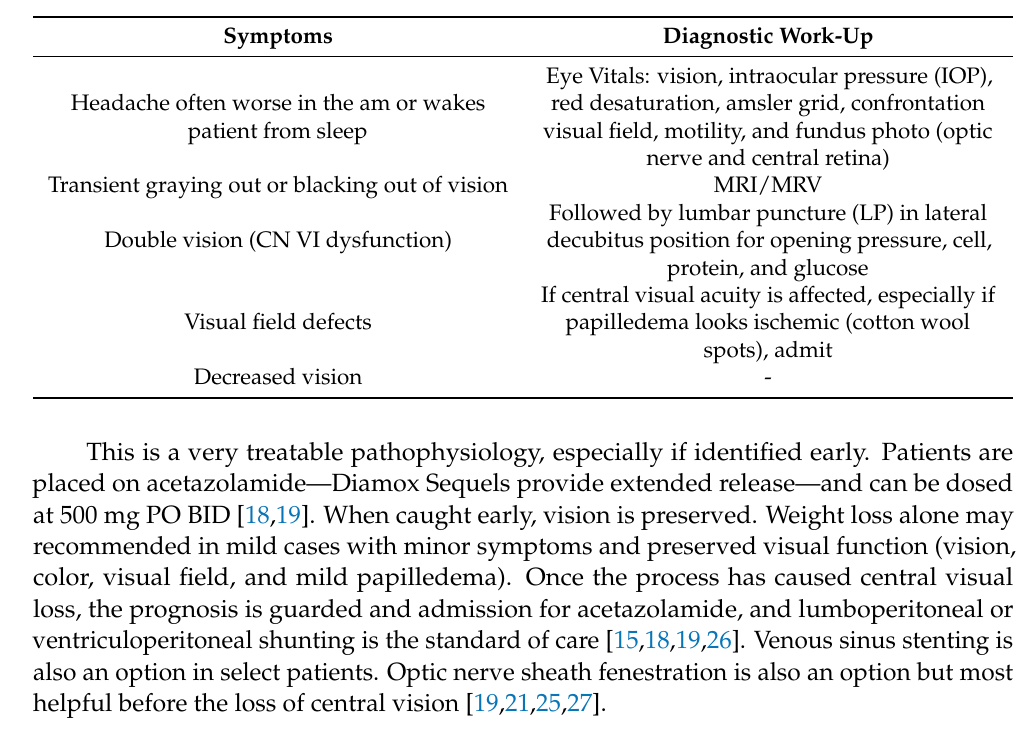
Table 3. Clinical manifestations of increased ICP and optimal management in the ED setting